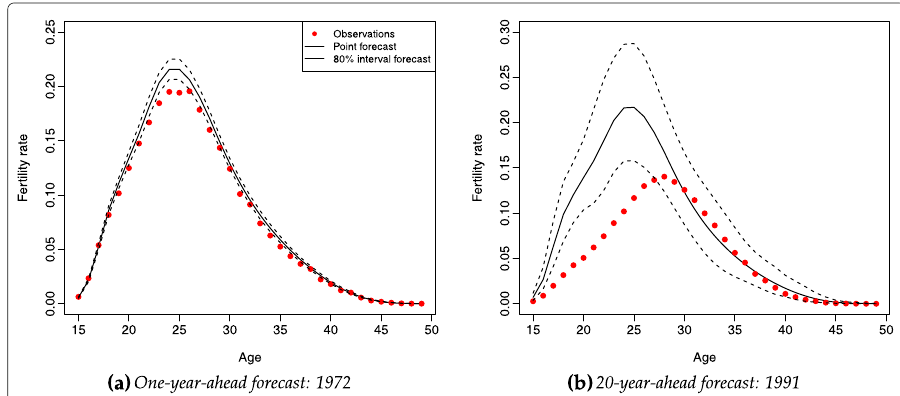
Fig. 3 Comparison of observed data with 1-year-ahead and 20-year-ahead point and interval forecasts of Australian ASFRs based on data for 1921–1971 using the HU model